Question: Briefly state, in one sentence, what is plotted here.
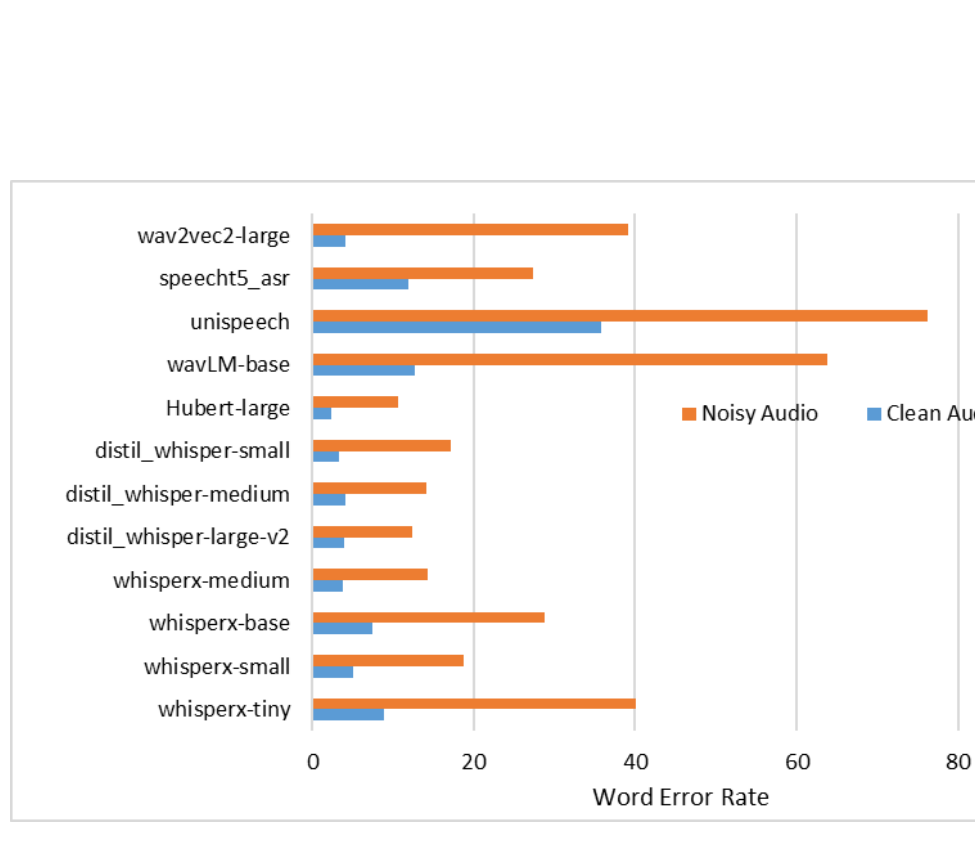
Answer: Impact of noisy audio input on the word error rate for tested models.